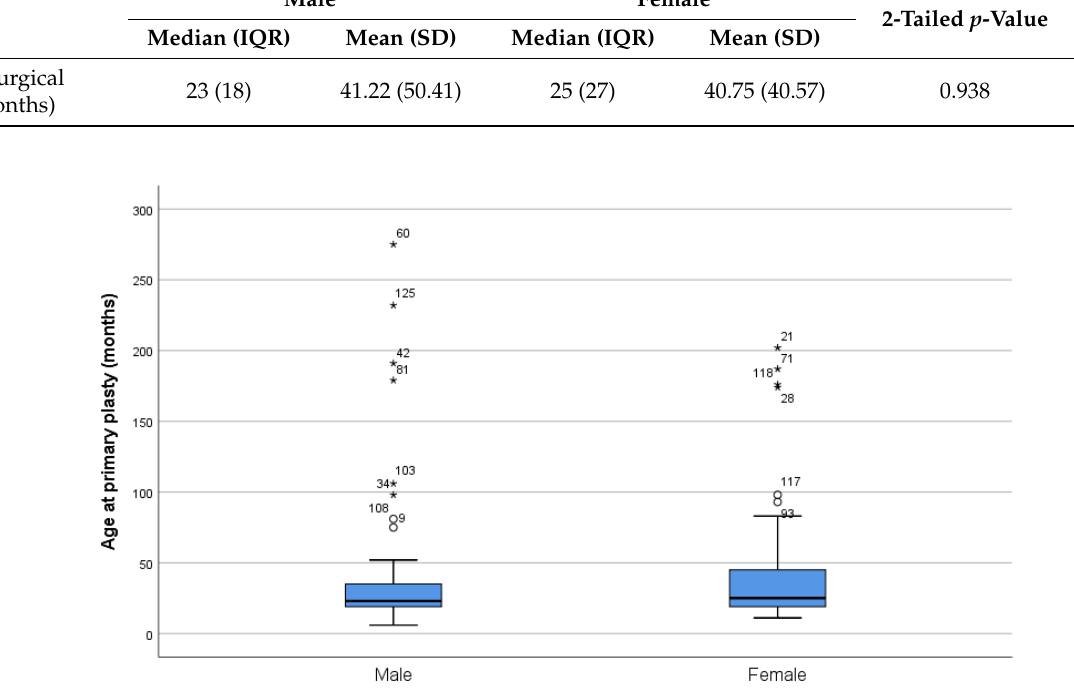
Table 1. Ages of the male and female patients at their primary surgical intervention.